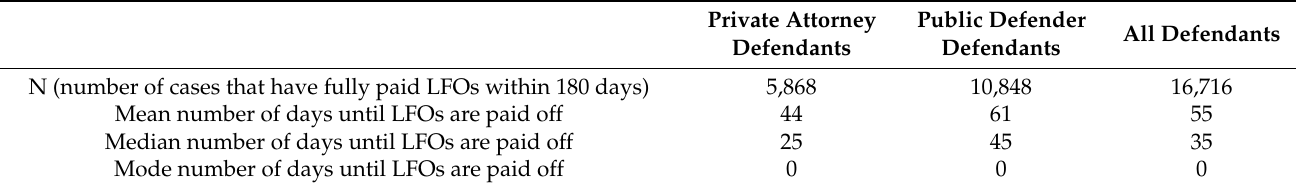
Table 4. Mean, median, and mode number of days until LFO debt is settled (of cases where LFO debt is settled within 180 days).